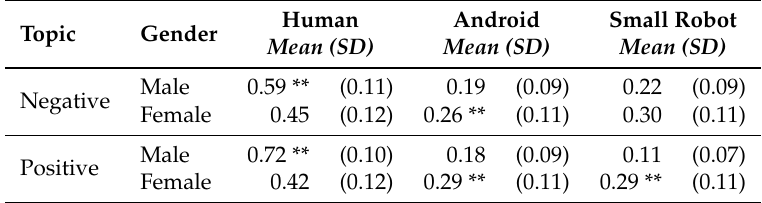
Table 4. Participant’s preference of self-disclosure listener (**: p <